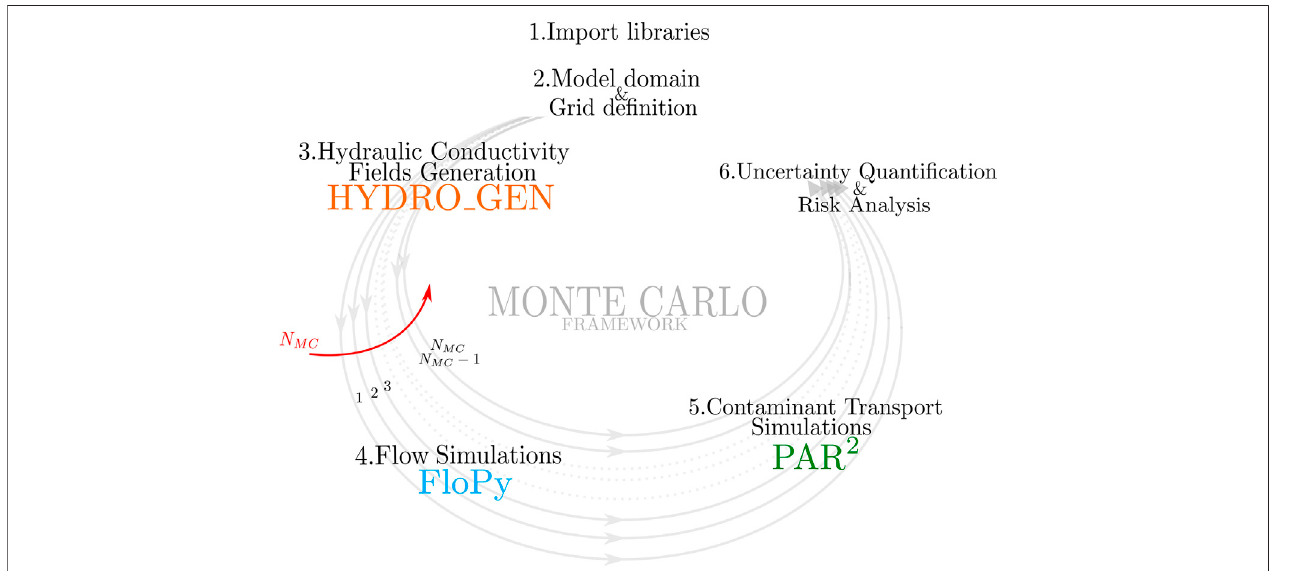
FIGURE 1 | A schematic representation of VisU-HydRA. As a computational toolbox for groundwater contaminant transport and its uncertainty, VisU-HydRA integratesallnecessarynumericalsoftwareandpost-processingcodesinasingleJupyterNotebook.Eachcomponent(1-6)isexecutedbyeachcodecellintheJupyter Notebook in order. Colored are the names of the employed software, and N MC stands for the number of Monte Carlo realizations.